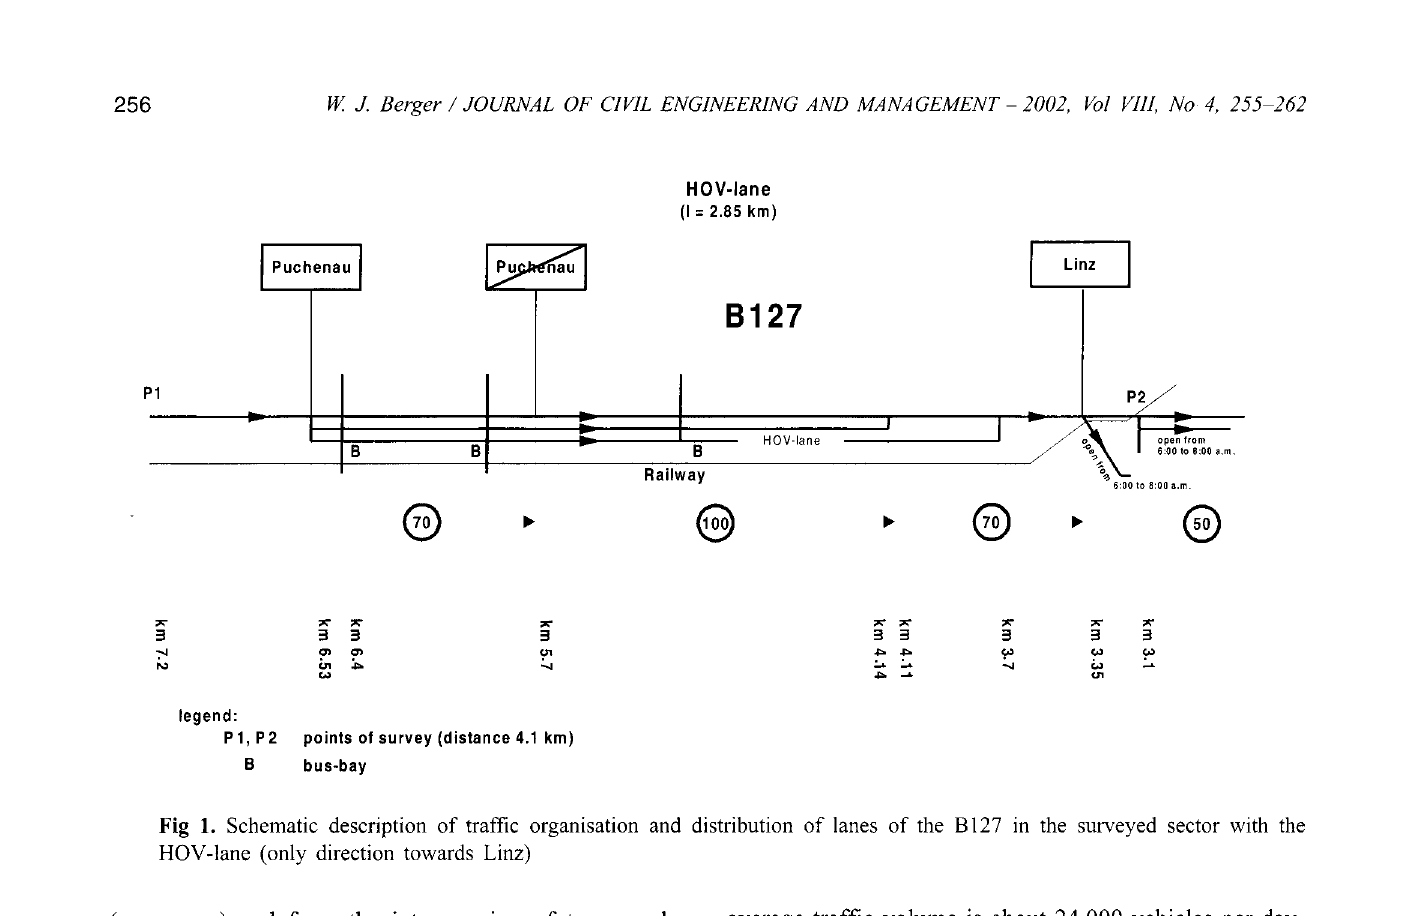
Fig 1. Schematic description of traffic organisation and distribution of lanes of the B 127 in the surveyed sector with the HOY-lane (only direction towards Linz)